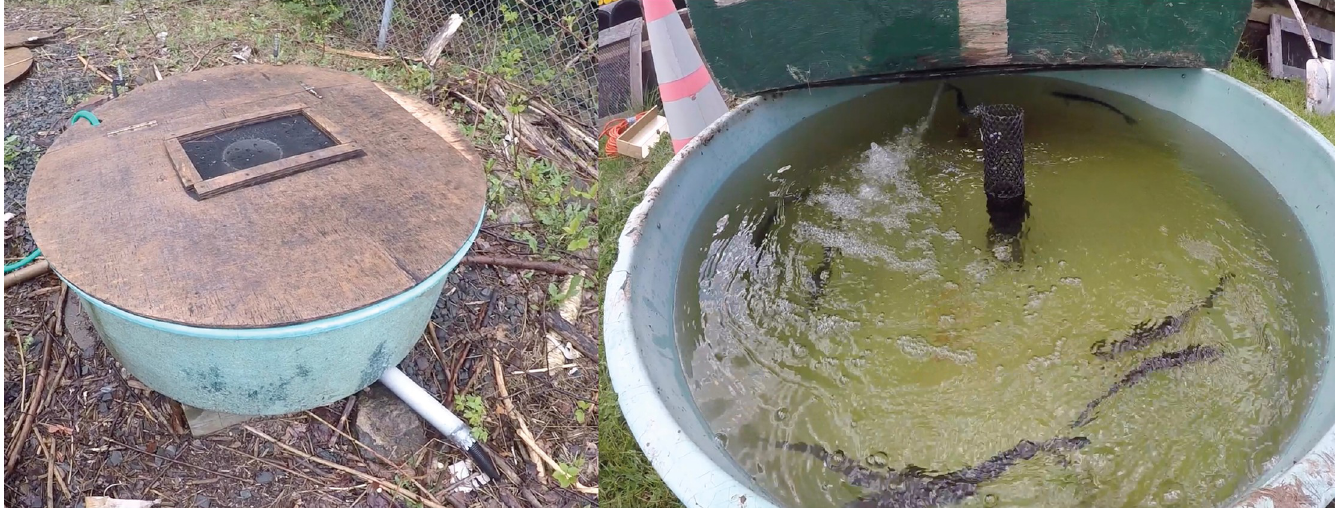
Fig 2. Pictures of holding tank (270 L) used to retain alewives during field trials at the White Rock Fish Ladder, Gaspereau River, Nova Scotia. Both the holding and recovery tanks were analogous and located outdoors near the fish ladder on Nova Scotia Power Inc property.